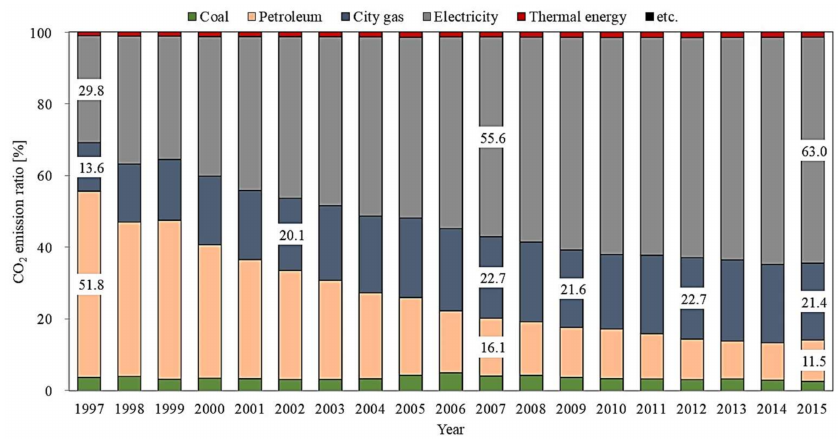
Figure 9. Percentage of greenhouse gas emission by energy source (%).